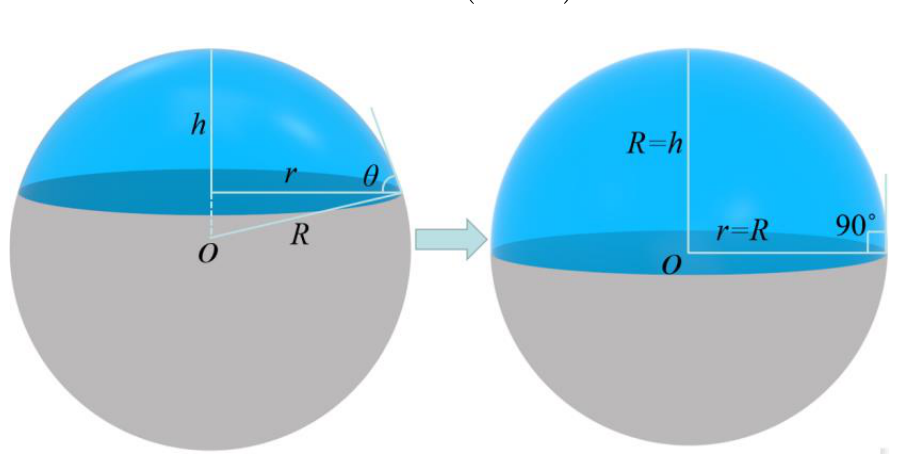
Figure 2. Schematic diagram of a spherical crown droplet. The droplet contact angle is 90 ◦ , so the evaporation process does not take into account the change in contact angle. The volume of the droplet at which R = r = h and at which the droplet is hemispherical is thus: V = 2 π R 3 /3 The velocity field u ( r , z ), the vapor concentration field c ( r , z ) and the temperature field T ( r , z ) within the droplet and in the surrounding air during the evaporation of the droplet can be described by the mass conservation equation, the momentum conservation equation and the energy conservation equation, respectively, as follows: